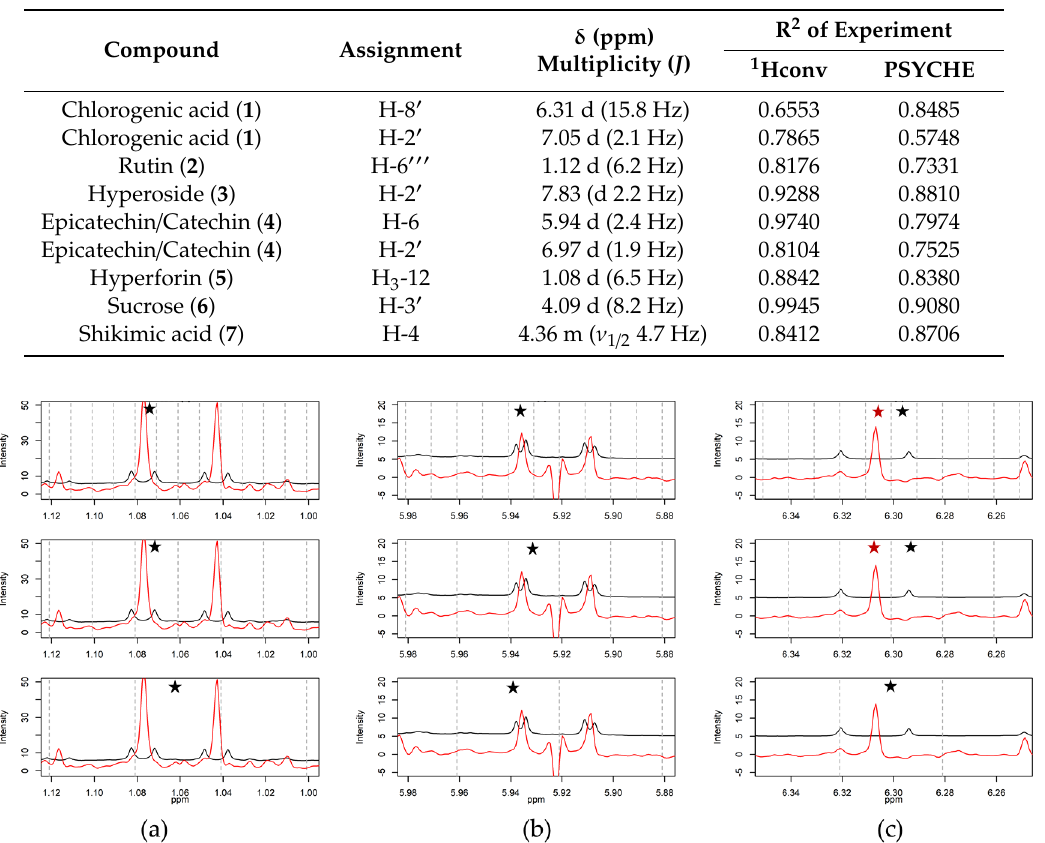
Table 1. Summary of the coe ffi cient of determination (R 2 ) after linear regression between 1 H-qNMR integrals and bin values of di ff erent experiments with bin size 0.02 ppm (Supplement S.2). Numbering scheme of compounds is shown in Figure S.1.